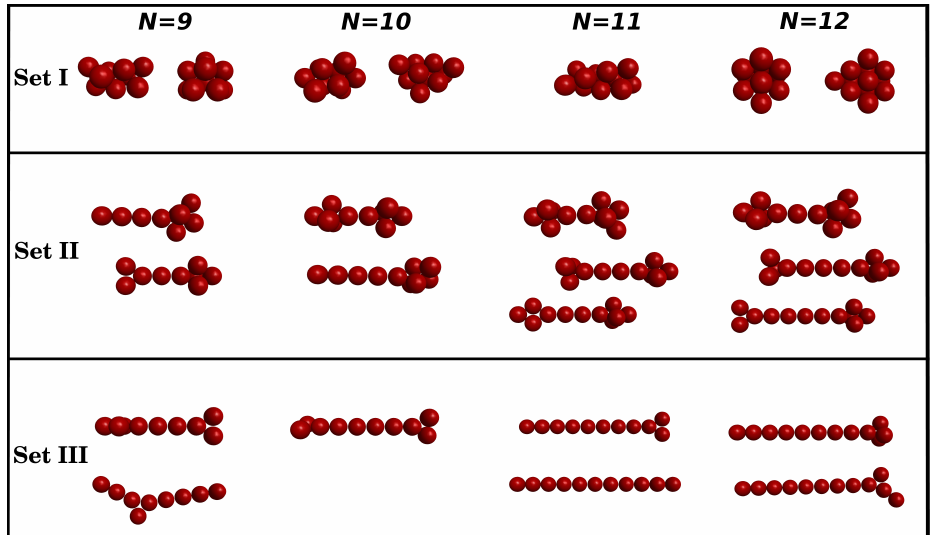
Figure 3. Main structural motifs from Set I, Set II and Set III of smaller colloidal clusters ( N = 9–12); see the main